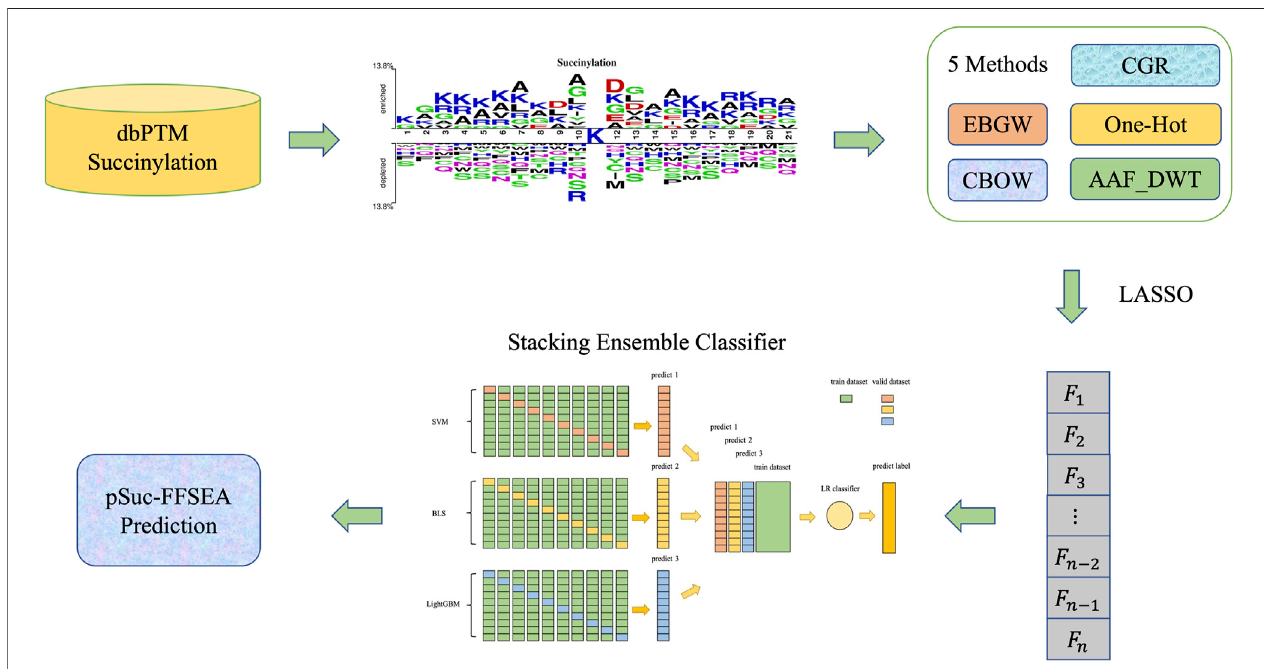
FIGURE 1 | The scheme diagram for establishing pSuc-FFSEA